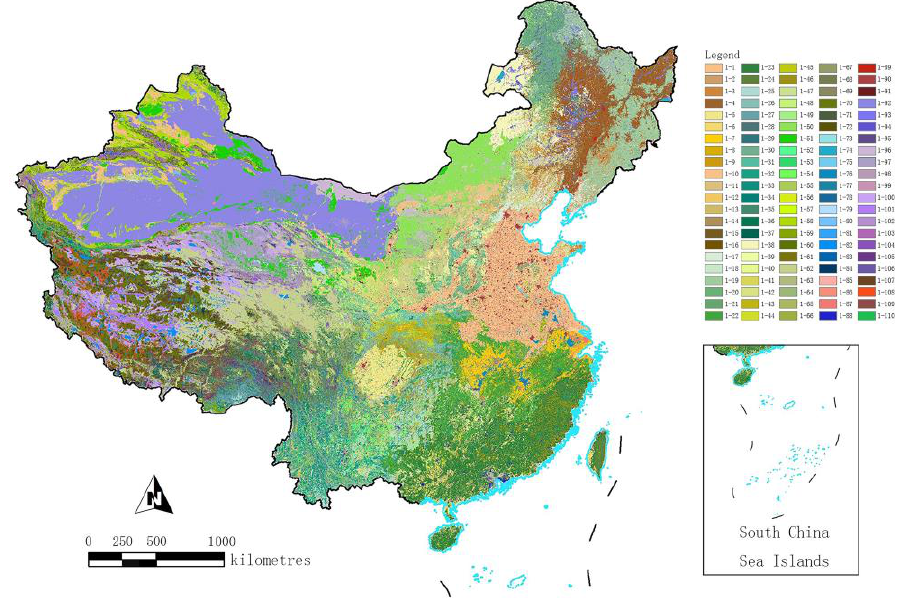
Figure 5. Map of 110 landscape character types (LCTs) across China at a scale of 1 × 1 km.